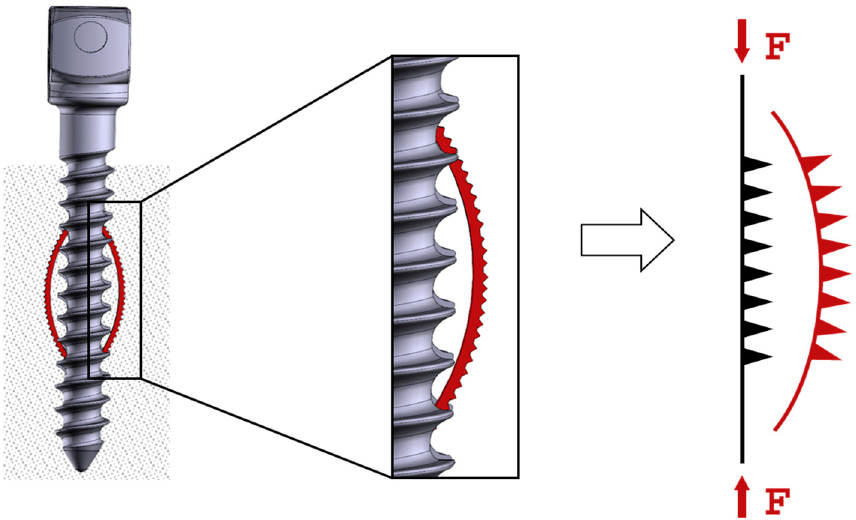
Figure 1. Operating principle of the hybridized anchoring element [18].